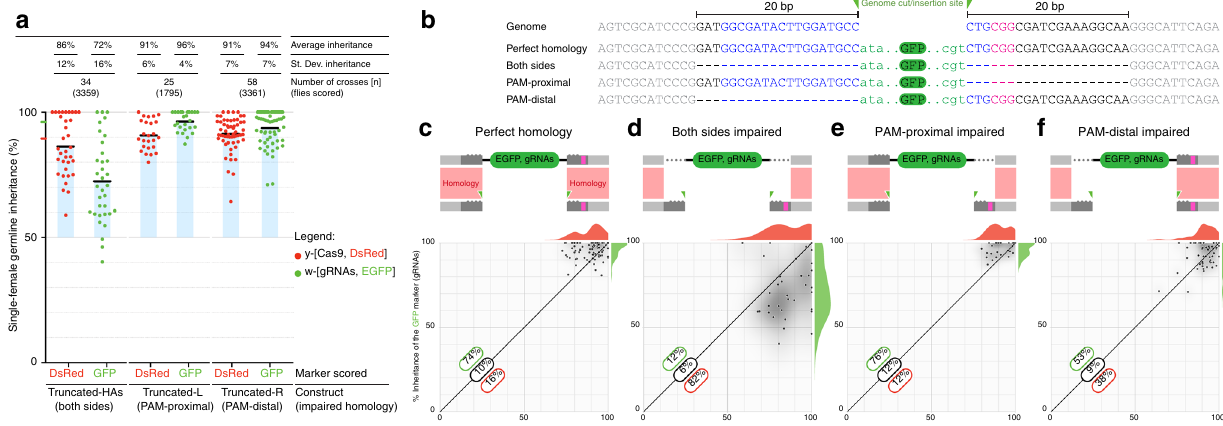
Fig. 5 Impaired homology arms affect drive ef fi ciency. a Inheritance rates of the three modi fi ed w- [ y1 , w2 ] gRNA lines (combined with vasa -Cas9 in yellow ) in which the homology ( b ) was impaired by removing 20 bp of sequence on both sides of the transgene (both sides), only on the PAM-proximal side (PAM proximal), or on the PAM-distal side (PAM distal). b Genomic and transgene sequences, 20 base pairs impaired homology sequences indicated in black, blue, and magenta; blue: gRNA target, magenta: PAM sequence, and green triangles highlight the cut location and gRNA-GFP transgene insertion site. GFP transgene is shown in green. Dashes highlight the missing sequences in the impaired homology constructs. The green (gRNA) and red (Cas9) markings on the y -axis in ( a ) indicate the average inheritance value of the control cross, with perfect homology, from Fig. 2a, e. c – f A schematic of each construct showing how the homology is impaired during the repair process. The bottom portion of the panel contains a 2D-correlation plot in which the inheritance of the DsRed-marked construct (Cas9) is represented on the x -axis, while the inheritance of the GFP-gRNA cassette is indicated on the y -axis. The individual data points are overlaid on a 2D-density distribution plot, and a 1D distribution of the data on each axis is also shown on the top and to he right of each graph. ( c ) Control: 2D-correlation graph of the data from Fig. 2 (perfect homology in both transgenes) representing the baseline. d Homology impaired on both sides of the gRNA transgene reduces allelic conversion of the GFP-marked construct. e Impaired homology on the PAM-proximal side behaves similarly to the control. f Impaired homology on the PAM-distal side seems to be slightly affected in terms of GFP inheritance, as individual data points are distributed almost equally on both sides of the diagonal. c – e Quanti fi cation of the percentage of data points falling over (green), on (black), and under (red) the midline is overlaid on each graph. Raw phenotypical scoring is provided as “ Supplementary Data 4 ”